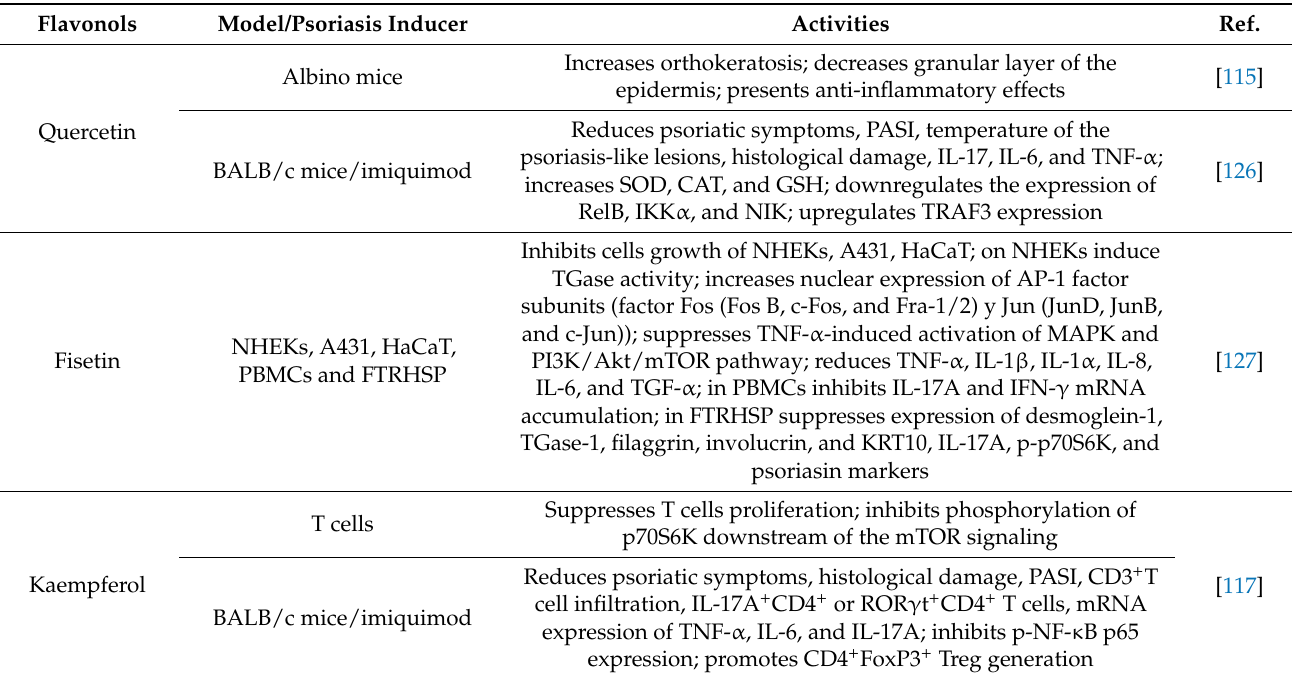
Table 7. Anti-psoriatic activity of the flavonols present in